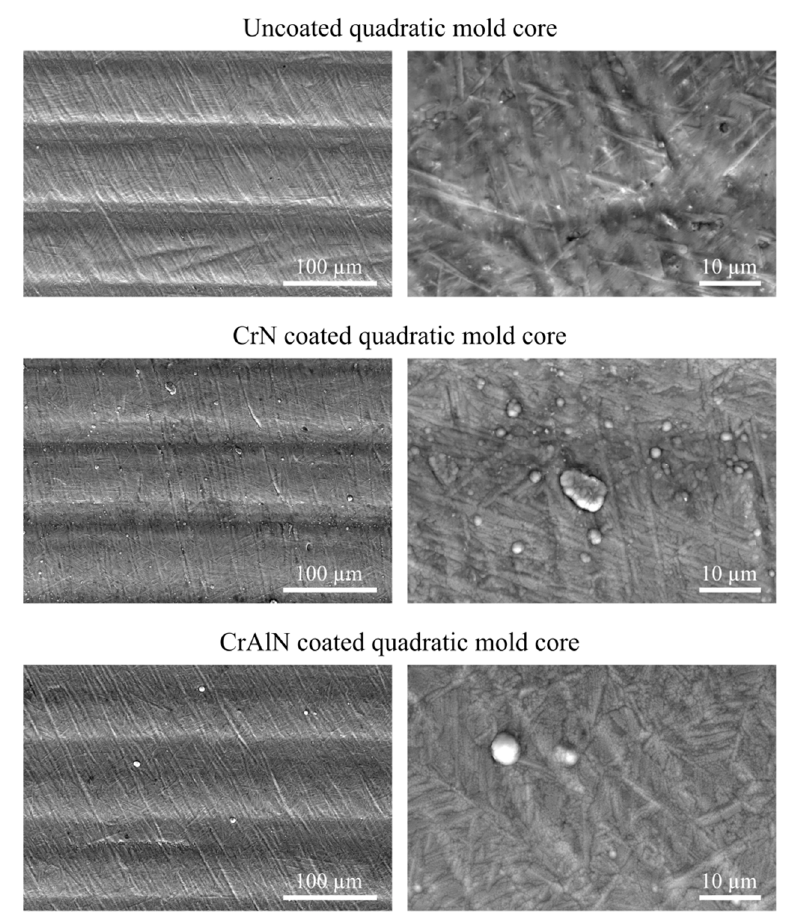
Figure 7. SEM micrographs of the core’s surfaces with a quadratic geometry.